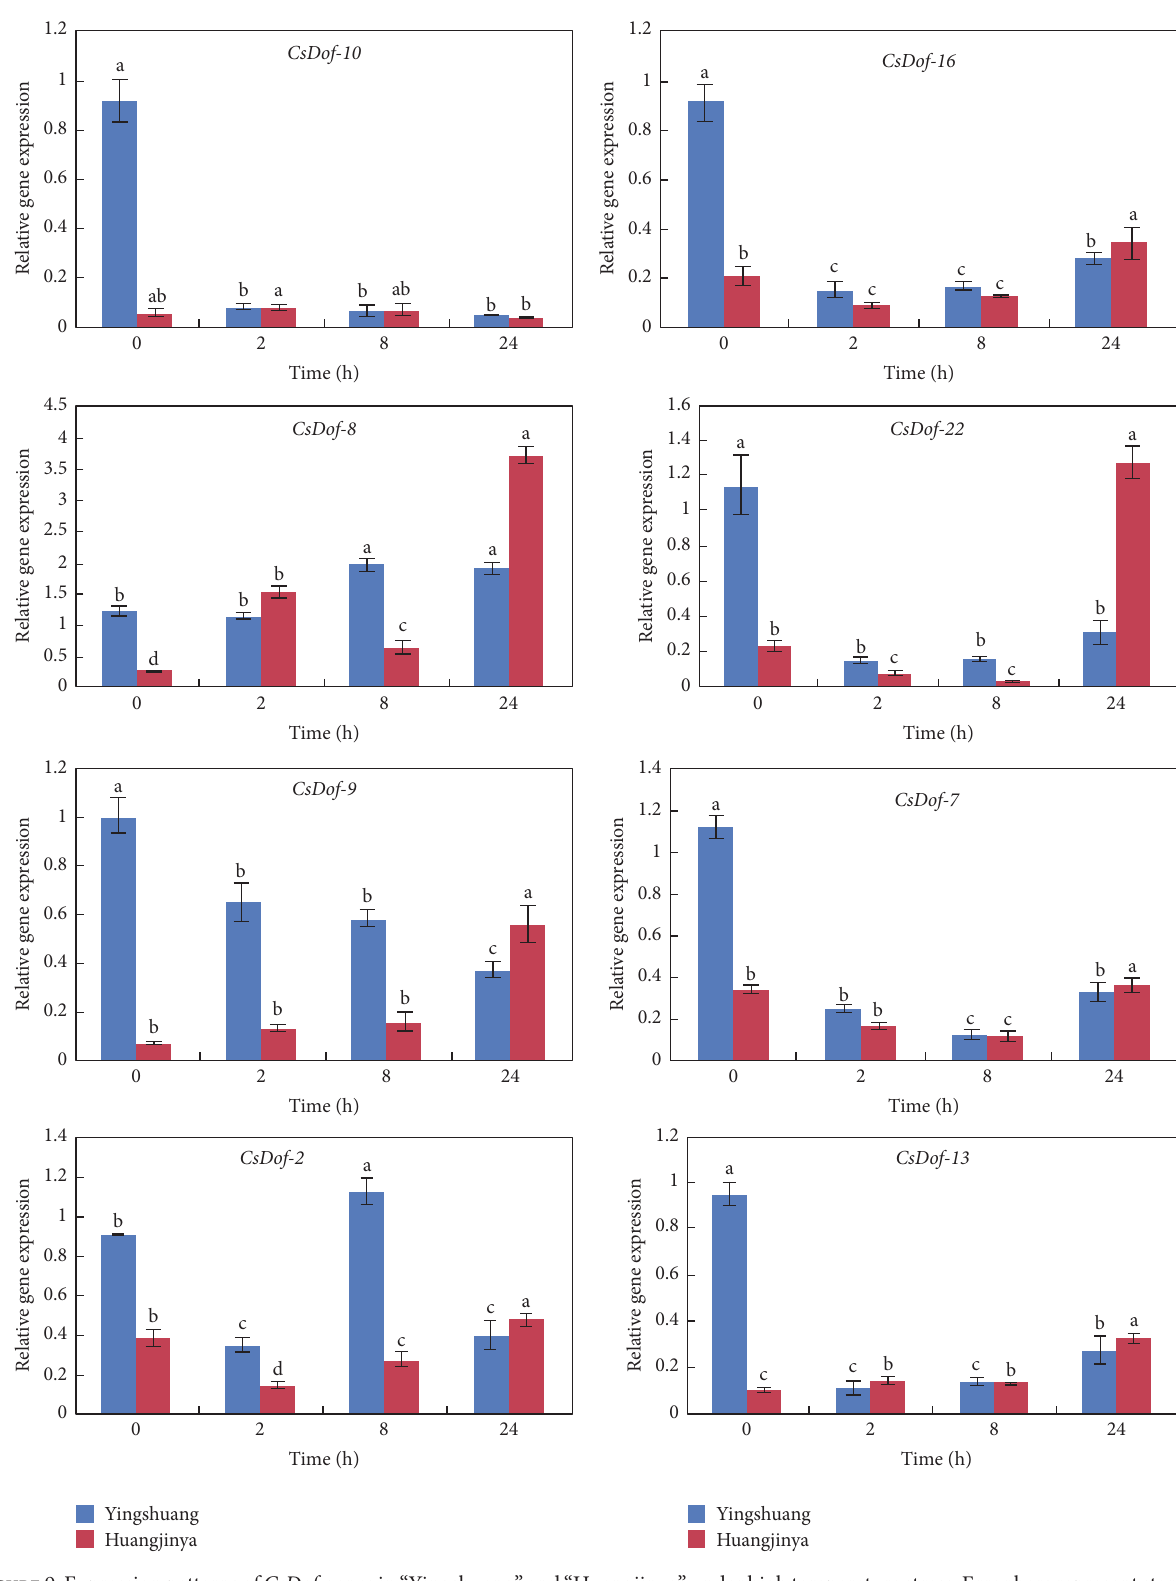
Figure9:Expressionpatternsof CsDof genesin“Yingshuang”and“Huangjinya”underhightemperaturestress.Errorbarsrepresentstandard deviation among three real-time quantitative PCR reaction replicates. Data are means of three technical replicates ± SD. Different lowercase letters indicate significant differences at 𝑃 < 0.05